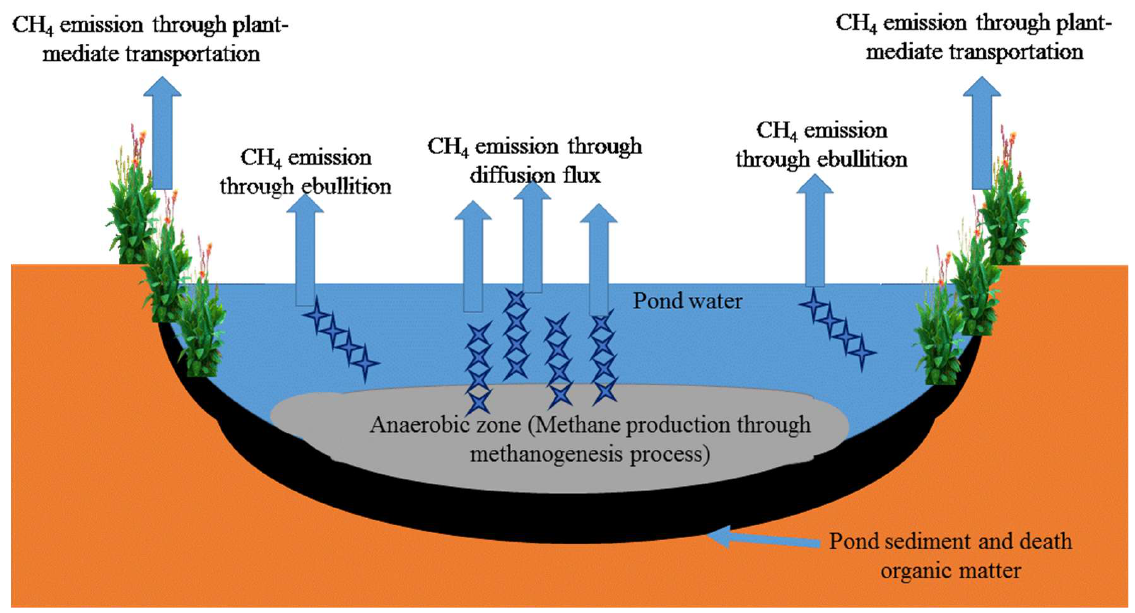
Figure 1. Pathway of methane emissions from a pond. Grinham et al. [16] investigated the CH 4 emissions from the pond and other small inland water bodies of Queensland, Australia, and found that ebullition is the